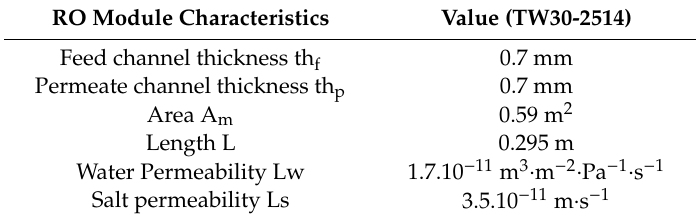
Table 2. Geometrical and transfer characteristics of the tested reverse osmosis (RO) module.